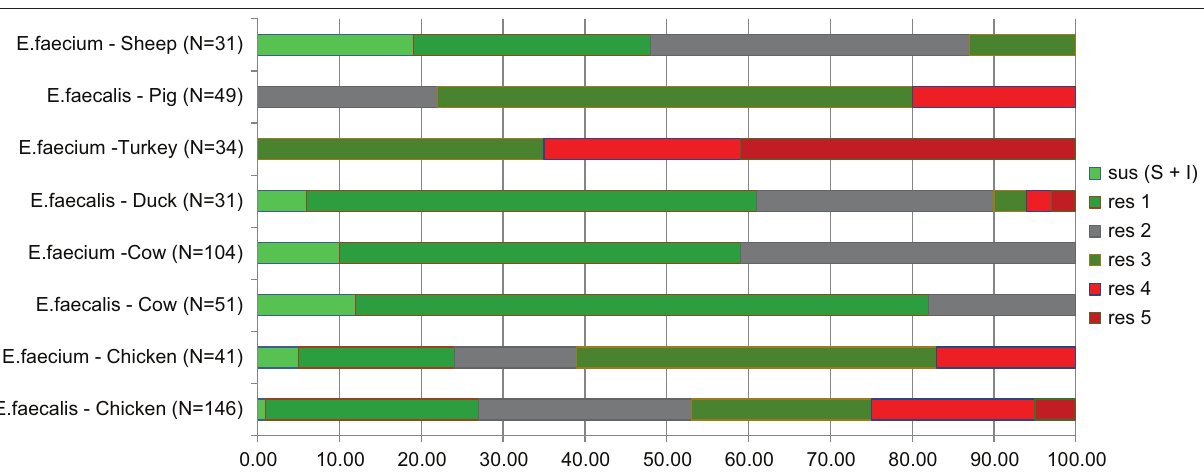
Figure-5: Patterns of simultaneous resistance to different classes of antimicrobials. Sus (S+I) means the percent of isolates susceptible to all antimicrobials tested (susceptible + intermediate categories according to CLSI 2021). Res 1 means the percent of isolates resistant to at least 1 antimicrobial, Res 2 – to 2 antimicrobials,